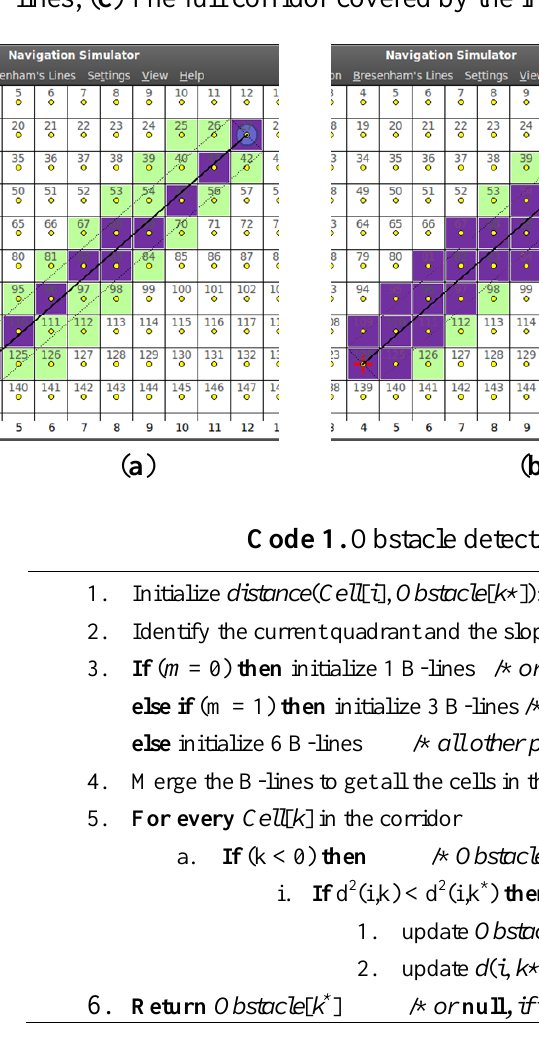
Figure 4. The three levels of coverage of the B-lines set. ( a ) The corridor and the cells covered by the internal B-lines; ( b ) The additional cells covered by the first-level external B-lines; ( c ) The full corridor covered by the inclusion of the second-level external B-lines.